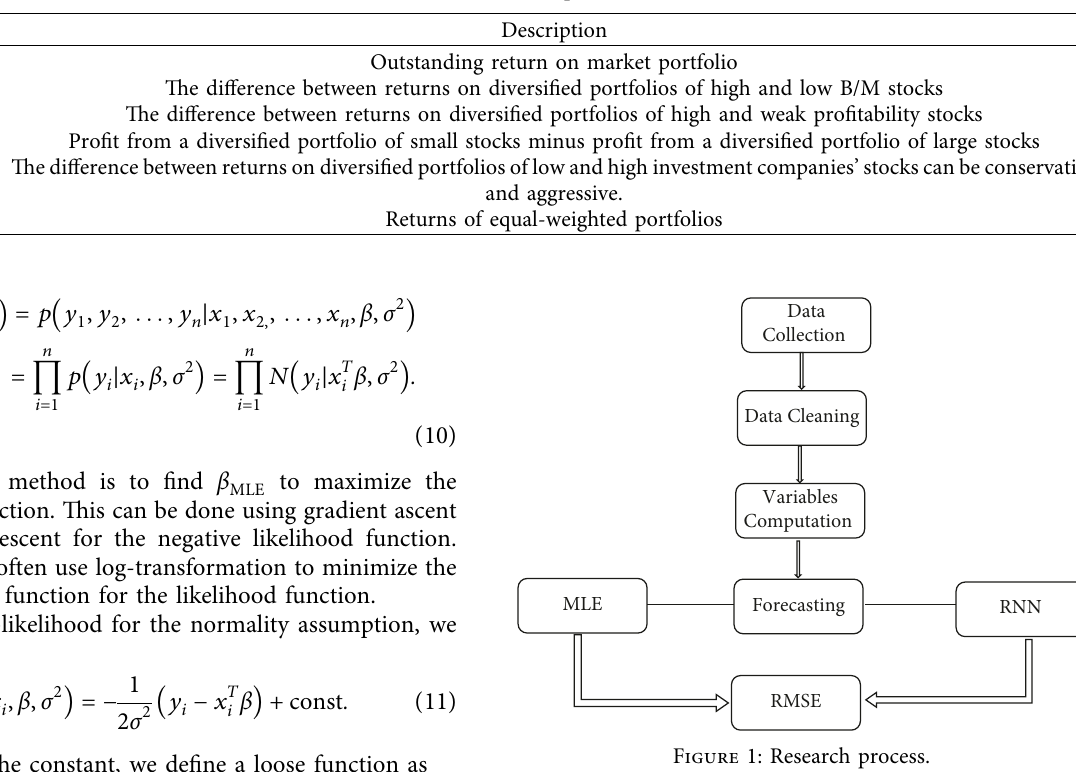
Table 1: Variable description.